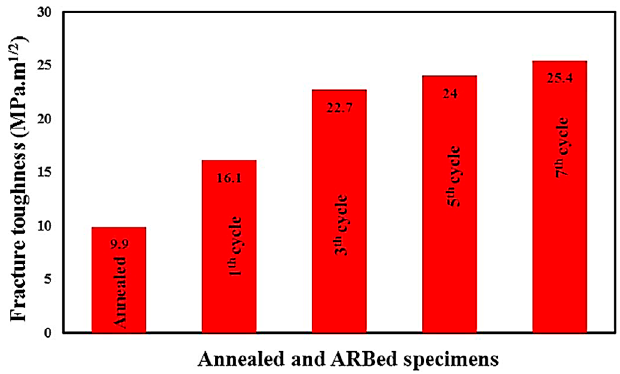
Figure 18. Plane stress fracture toughness of the ARBed Al 1050 specimens for different cycles [122].